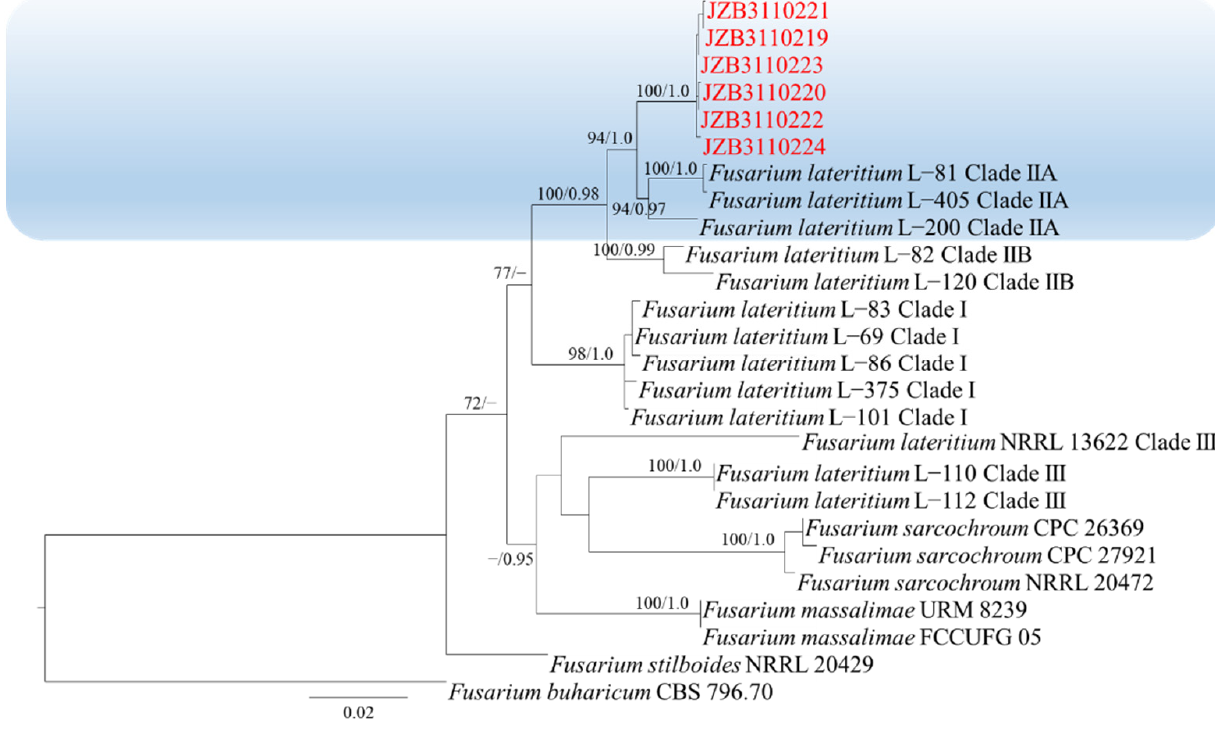
Figure 3. Phylogenetic tree generated by maximum likelihood analysis (RAxML) of FLSC based on the combined rpb2 , tef1 and tub2 sequence data. The tree is rooted with Fusarium buharicum (CBS 796.70). The best-scoring RAxML tree with a final likelihood value of − 5602.556442 is presented. The matrix had 358 distinct alignment patterns, with 32.15% being undetermined characters or gaps. Estimated base frequencies were as follows: A = 0.236754, C = 0.282131, G = 0.242563, T = 0.238552; substitution rates AC = 2.260928, AG = 7.239234, AT = 2.341489, CG = 1.331525, CT = 16.787035, GT = 1.000000; gamma distribution shape parameter α = 1.252177. ML bootstrap support values ≥ 50% and Bayesian posterior probabilities (BYPP) ≥ 0.95 are given near the nodes. The scale bar indicates 0.02 changes per site. Isolates belonging to this study are given in red.